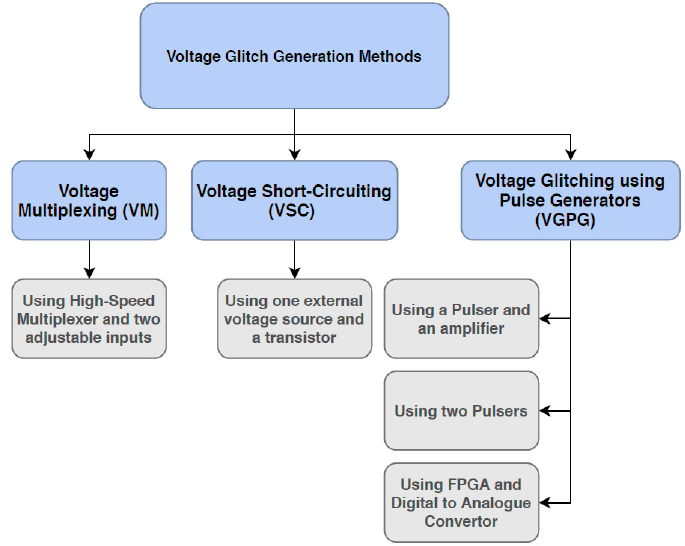
Figure 15. Different methods for generating voltage glitches. Figure 15. Di ff erent methods for generating voltage